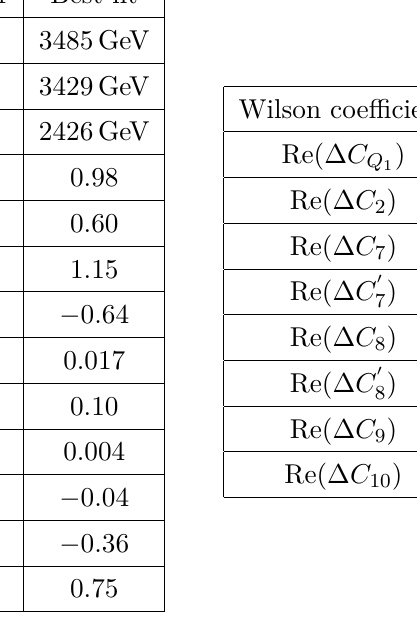
Table 5 . Best fit values for the scan parameters (left) and WCs for b → sµ + µ − transitions (right). We show only Re(∆ C Q and m s /m b Re(∆ C Q